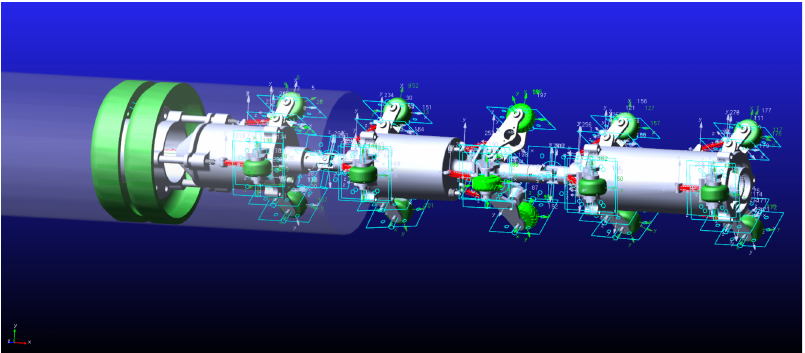
Figure 8. Virtual prototype model of the pipeline endoscope robot in ADAMS after adding the constraint.